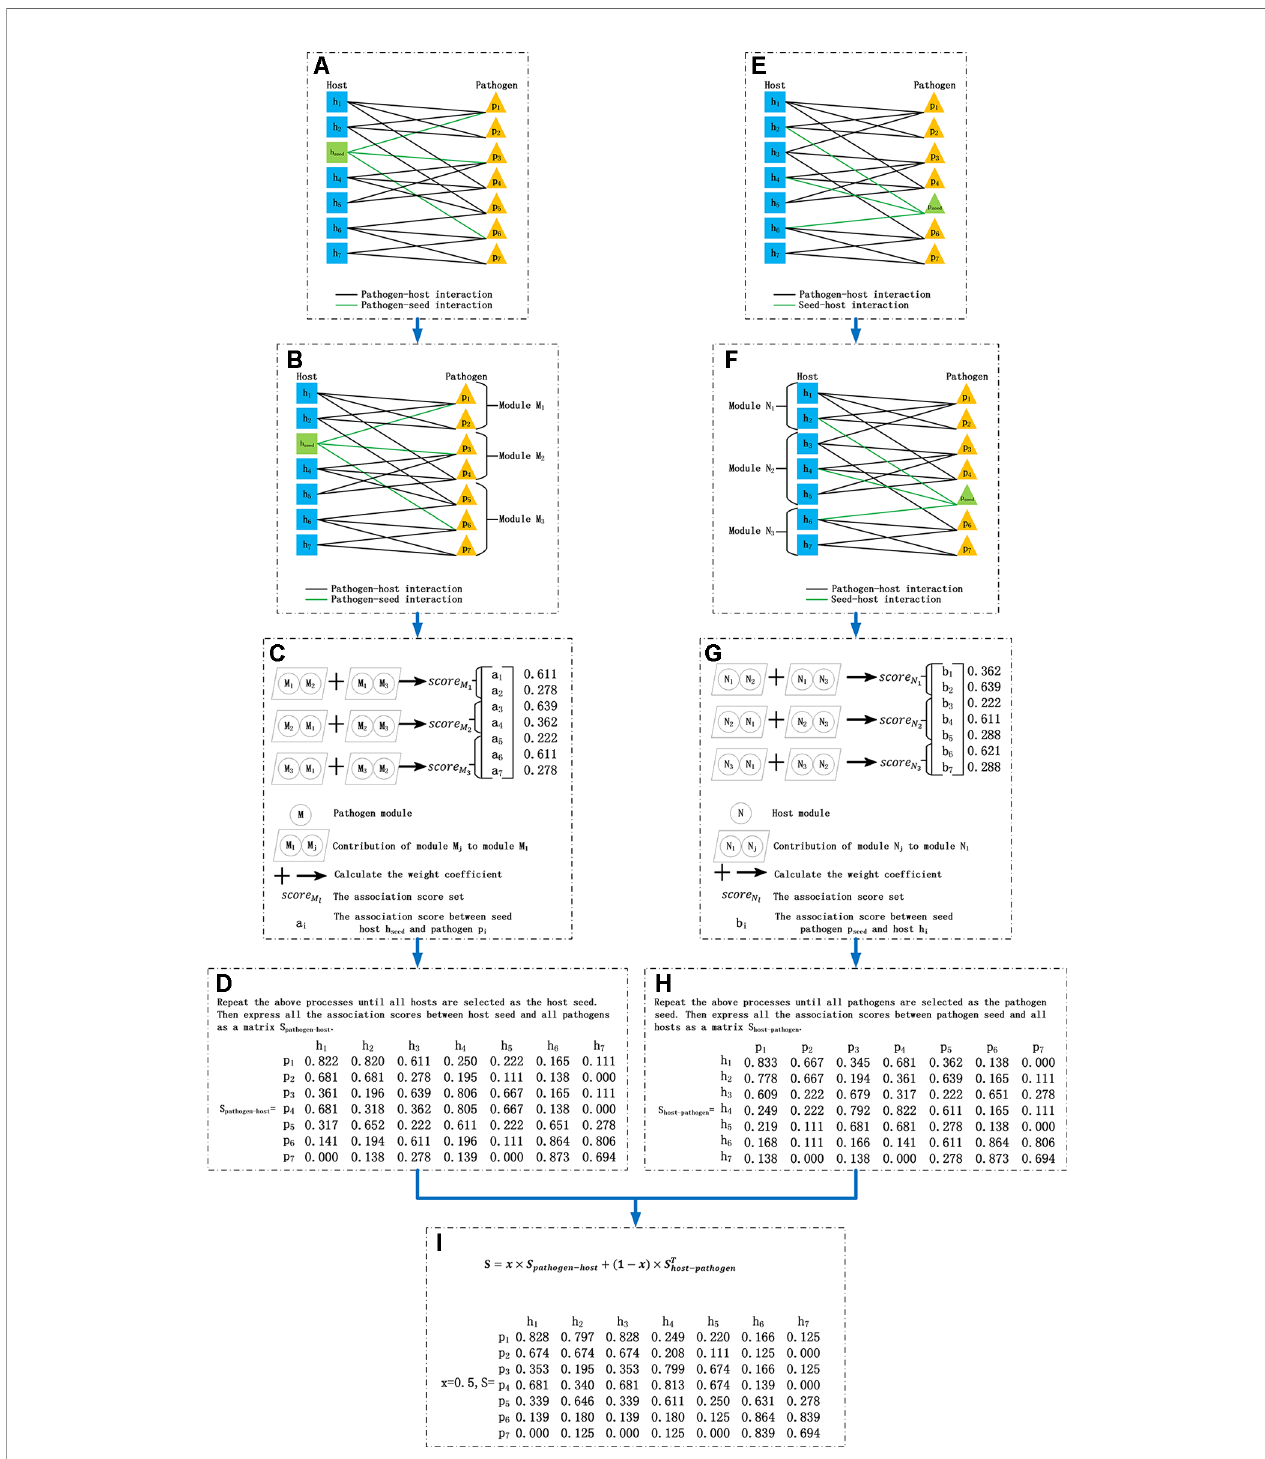
FIGURE 1 | Process of the bipartite network module-based project. (A) Construct the pathogen – host bipartite network and choose a host as the seed vertex. (B) Divide the pathogen set into several modules. (C) Calculate the association score between the seed and pathogens in each module. (D) Select each host as the seed vertex in turn and repeat process (A – C) then obtain the pathogen – host association score matrix S pathogen − host (E) Choose a pathogen as the seed vertex. (F) Divide the host set into several modules. (G) Calculate the association score between the seed and hosts in each module. (H) Select each pathogen as the seed vertex in turn and repeat process (E – G) then obtain the host – pathogen association score matrix S host − pathogen . (I) Integrate matrix S pathogen − host and S host − pathogen as the association score matrix between all pathogens and